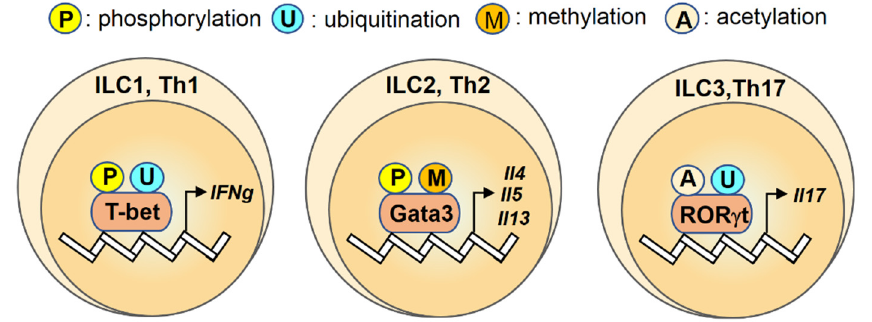
Figure 1. An overview of regulation for transcription factors T-bet, Gata3, ROR γ t by post-translational modifications (PTMs) in innate lymphoid cells (ILCs) and T helper cells. Transcription factors T-bet, Gata3 and ROR γ t are regulated by the post-translational modifications (P: phosphorylation; U: ubiquitination; M: methylation; A: acetylation) and the color di ff erences indicate various modifications on their targets.